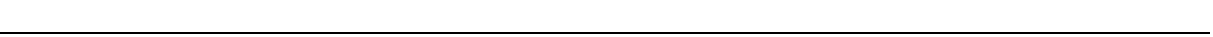
Fig. 2 p16 Ink4a and p21 Cip1/Waf1 in Mo-MDSCs promote tumour progression and the number of intratumoral Mo-MDSCs is decreased in p16/p21- DKO mice. a , b Tumour size in SCT-injected male WT and p16/p21-DKO mice ( a ) and female WT and p16/p21-DKO mice ( b ); the number of mice of each genotype is indicated in the data series. c , d Tumour size in WT mice subcutaneously injected with SCT cells simultaneously with adoptive transfer of WT or p16/p21-DKO Mo-MDSCs ( c ) and PMN-MDSCs ( d ) via the tail vein. e Tumour size in WT mice subcutaneously injected with a mixture of SCT cells and WT or p16/p21-DKO Mo-MDSCs. f Representative images of tumour slices of mice in which CSFE-labelled Mo-MDSCs from WT or DKO mice were injected intravenously (i.v.) or subcutanously (intratumour). Tumours were extirpated 21 days after injection. Signals indicate CSFE-labelled cells. Scale bars indicate 50 μ m. g Representative fl ow cytometry plots of CD45 + CD11b + -gated cells in BM (upper panels), spleen (middle panels), and tumour (lower panels) from WT and p16/p21-DKO mice 3 weeks after SCT cell injection. Cells were labelled with CD45, CD11b, Ly6C and Ly6G antibodies. h Mean populations of CD11b + Ly6C high Ly6G − (Mo) cells and CD11b + Ly6G + (PMN) cells in the CD45 + -gated cells are shown in f ( n = 5); data are presented as mean ± SEM. The statistical signi fi cance was determined by Student ’ s t- test; * p < 0.05, ** p < 0.01 and *** p < 0.001; NS not signi fi